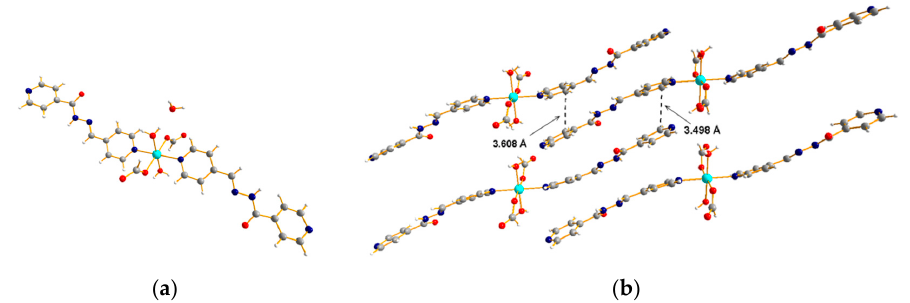
Figure 1. ( a ) Unit Structure of [Zn(pytz(hydrolyzed)) 2 (OH 2 ) 2 (OCOCH 3 ) 2 ]·H 2 O; ( b ) Possible π stacking interactions between 1D chains; Zn ( cyan ), C ( grey ), H ( white ), N ( blue ), O ( red